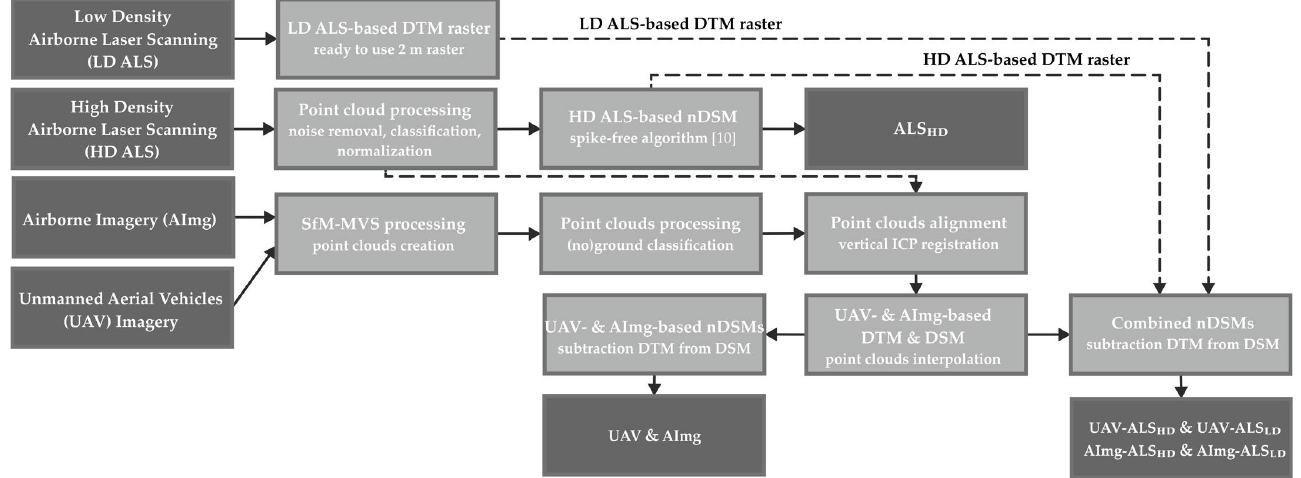
Figure 3. Description of the study workflow and the preparation of individual